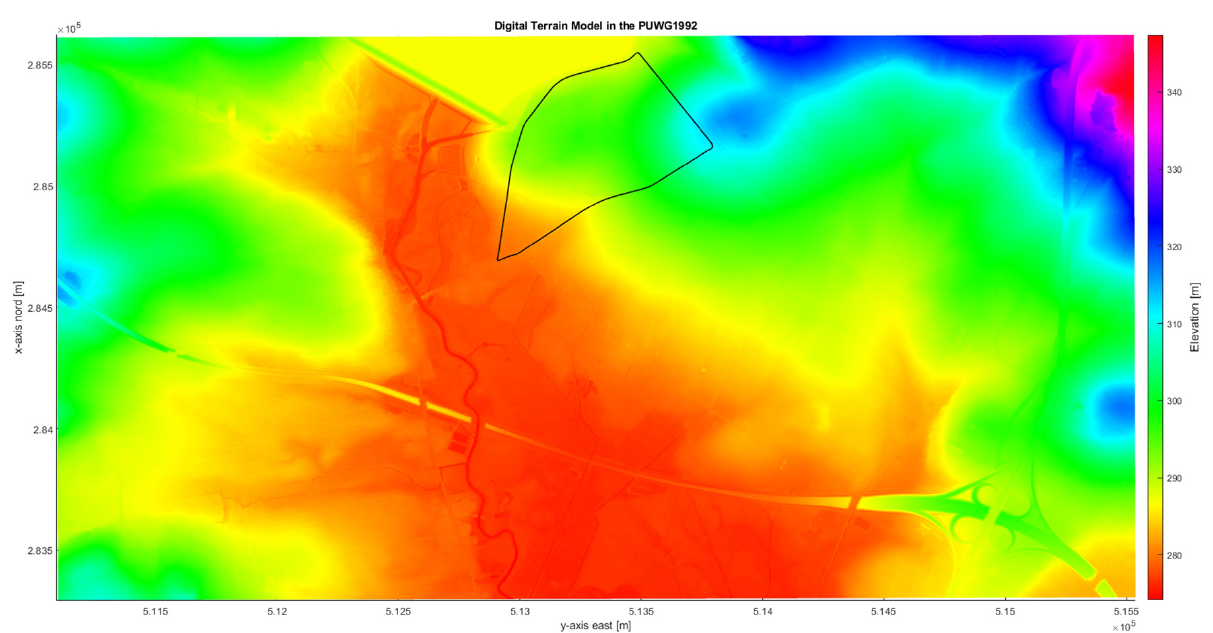
Figure 8. DTM altitude map.